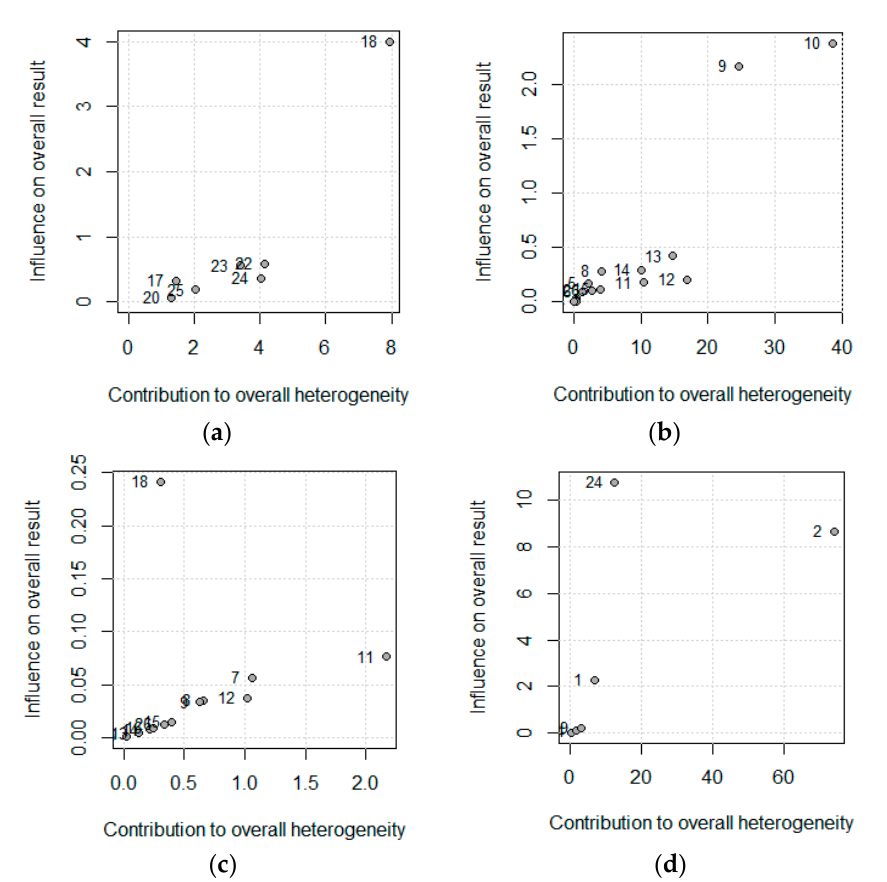
Figure 4. Baujat plot for ( a ) Crohn’s Disease Activity Index (CDAI), ( b ) Albumin ( c ) Body Weight, and ( d ) Postoperative complications. The correspondence between the study and the number is shown in Table 2 (Id, Omitting).